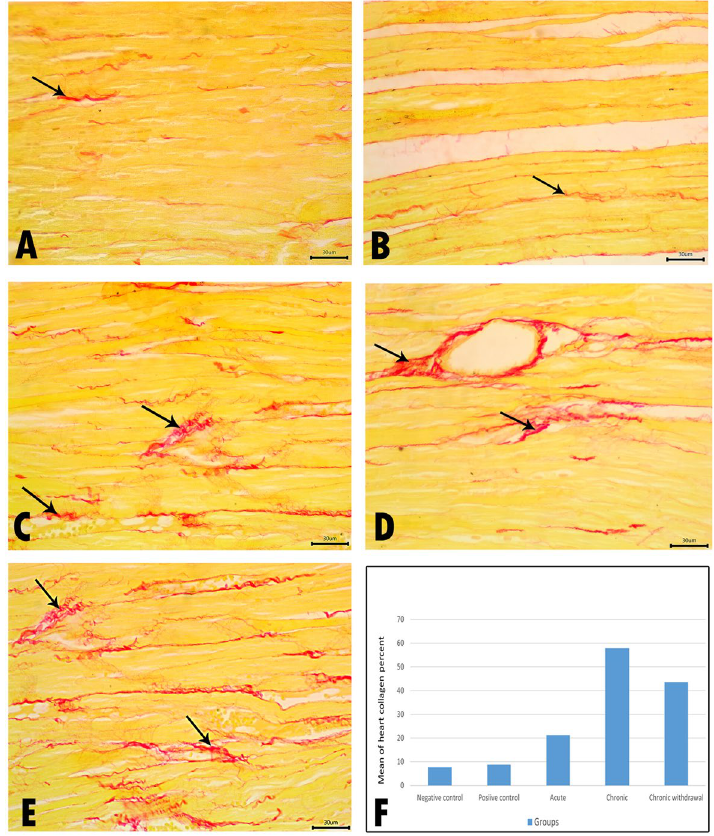
Fig. 12 Photomicrographs of the longitudinal sections of left ventricular heart muscles stained with SR ( 400). A and B Negative and positive × control groups show few collagen fibers between cardiac muscle fibers (arrow). While acute, chronic, and chronic withdrawal groups C , D , and E : reveal increased collagen fibers between cardiac muscle fibers compared to the control group (arrows). F : showing the mean area % of collagen fibers in all groups. Data are expressed as mean SD; P 0.001 for control groups vs acute, chronic and chronic withdrawal ∓ ≤